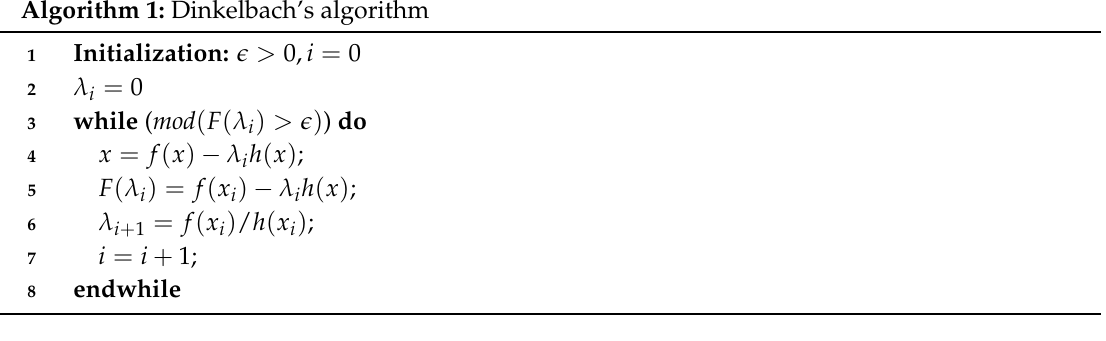
Algorithm 1: Dinkelbach’s algorithm